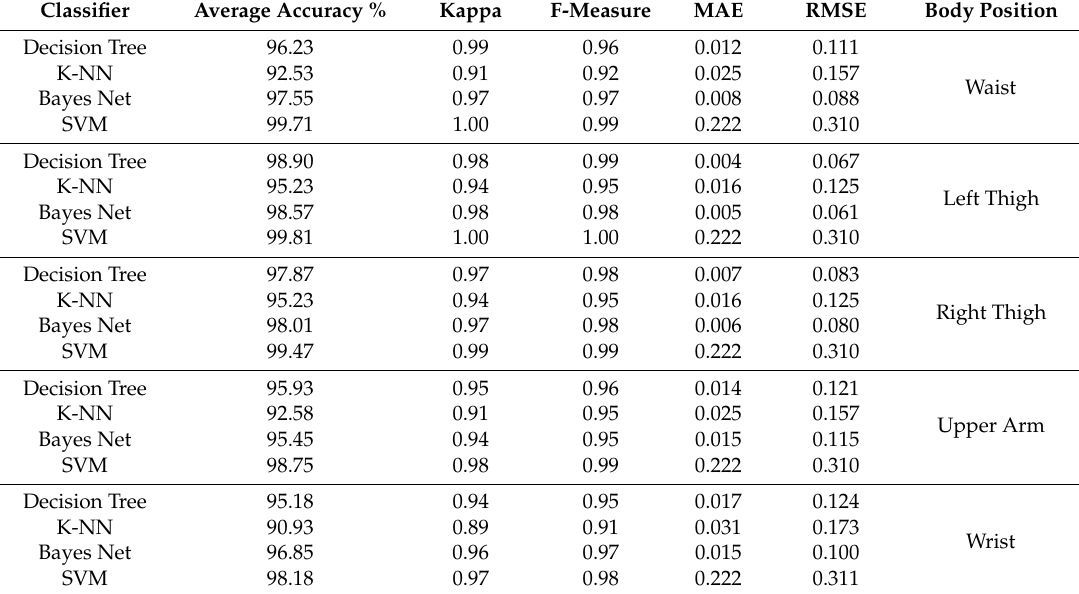
Table 5. Performance metrics of the selected classifiers for activity recognition at five body positions.